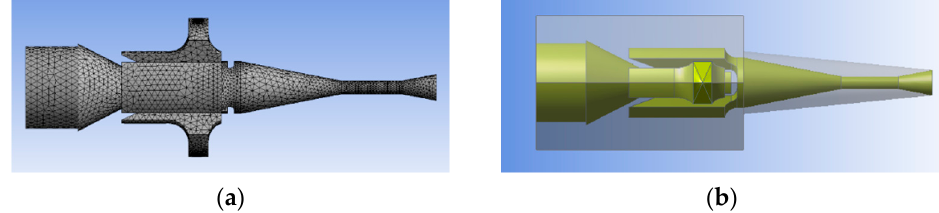
Figure 19. Seed suction nozzle grid and internal fluid domain diagrams. ( a ) Internal grid diagram. ( b ) Internal fluid domain diagram.